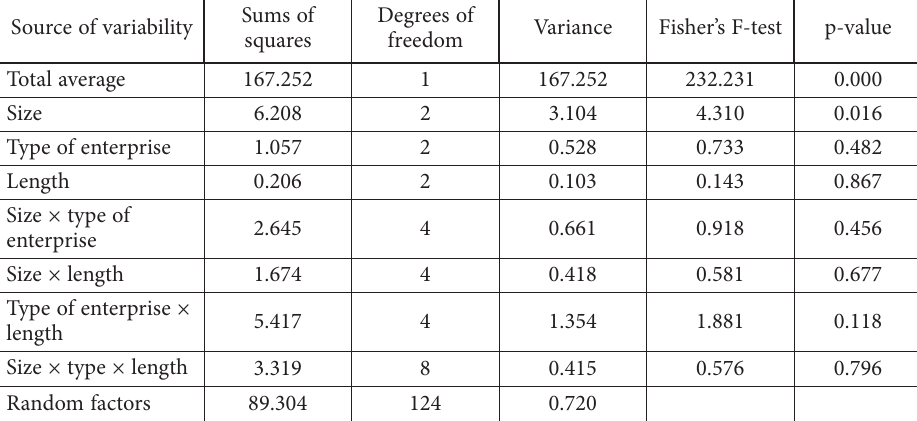
Table 2. Three-factor analysis of variance V1 Source of variability